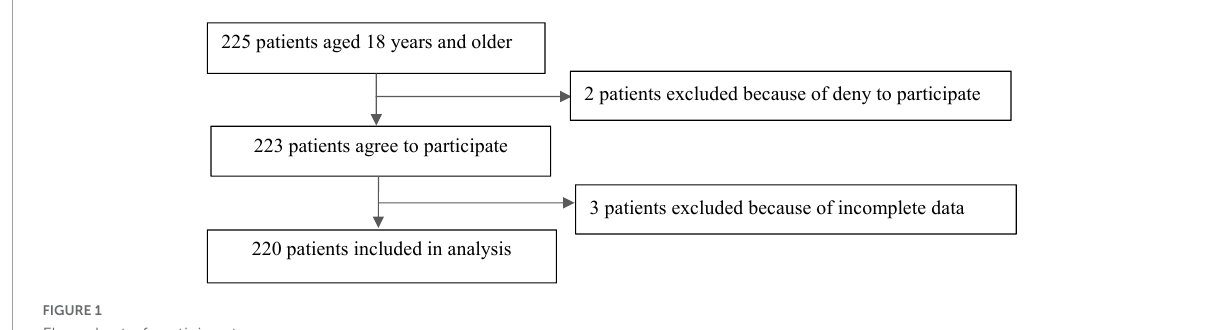
FIGURE1 Flow chart of